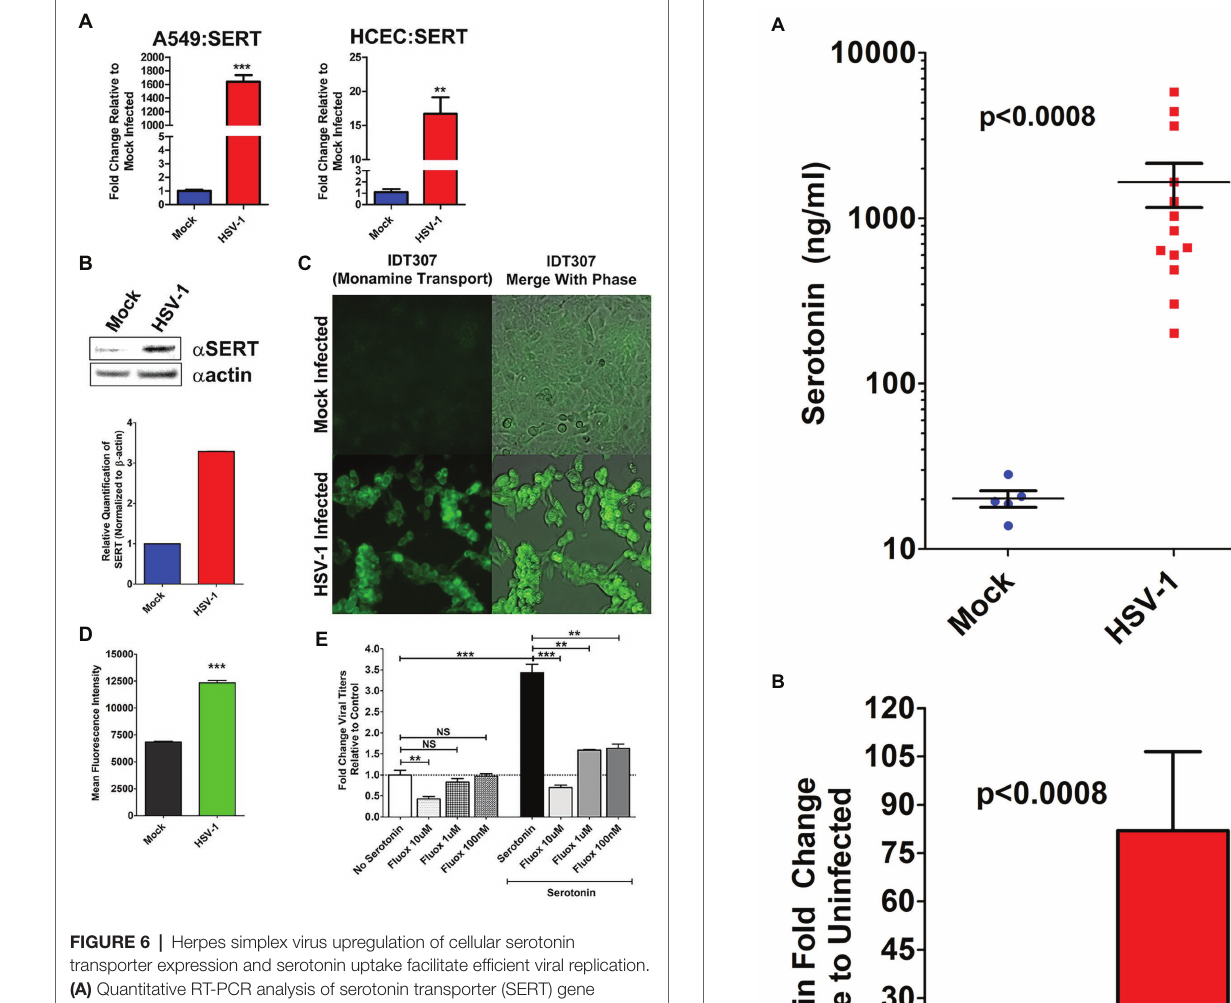
FIGURE 6 | Herpes simplex virus upregulation of cellular serotonin transporter expression and serotonin uptake facilitate efficient viral replication. (A) Quantitative RT-PCR analysis of serotonin transporter (SERT) gene expression in mock infected vs. HSV-1-infected A549 and HCEC cells. (B) Western blot analysis of SERT protein expression in mock-infected vs. HSV-1 infected cells. Relative quantification was performed by normalizing band density to β -actin. (C) Representative fluorescent micrographs depicting enhanced uptake of the fluorescent serotonin surrogate IDT307 monoamine in mock or HSV-infected cells. (D) Quantitative assessment of mean fluorescent intensity (MFI) following fluorescent IDT307 in Mock or HSV-1 infected cells. (E) HSV-1 infected cells were treated with the serotonin reuptake inhibitor, Fluoxetine at 10 μ M, 1 μ M, or 100 nM in the presence of 50 μ M serotonin. Relative viral yields were determined by limiting dilution plaque assays and compared to No Serotonin Controls. Data are graphed as mean ± SEM. (** p < 0.01, *** p < 0.001, and NS Not Significant).